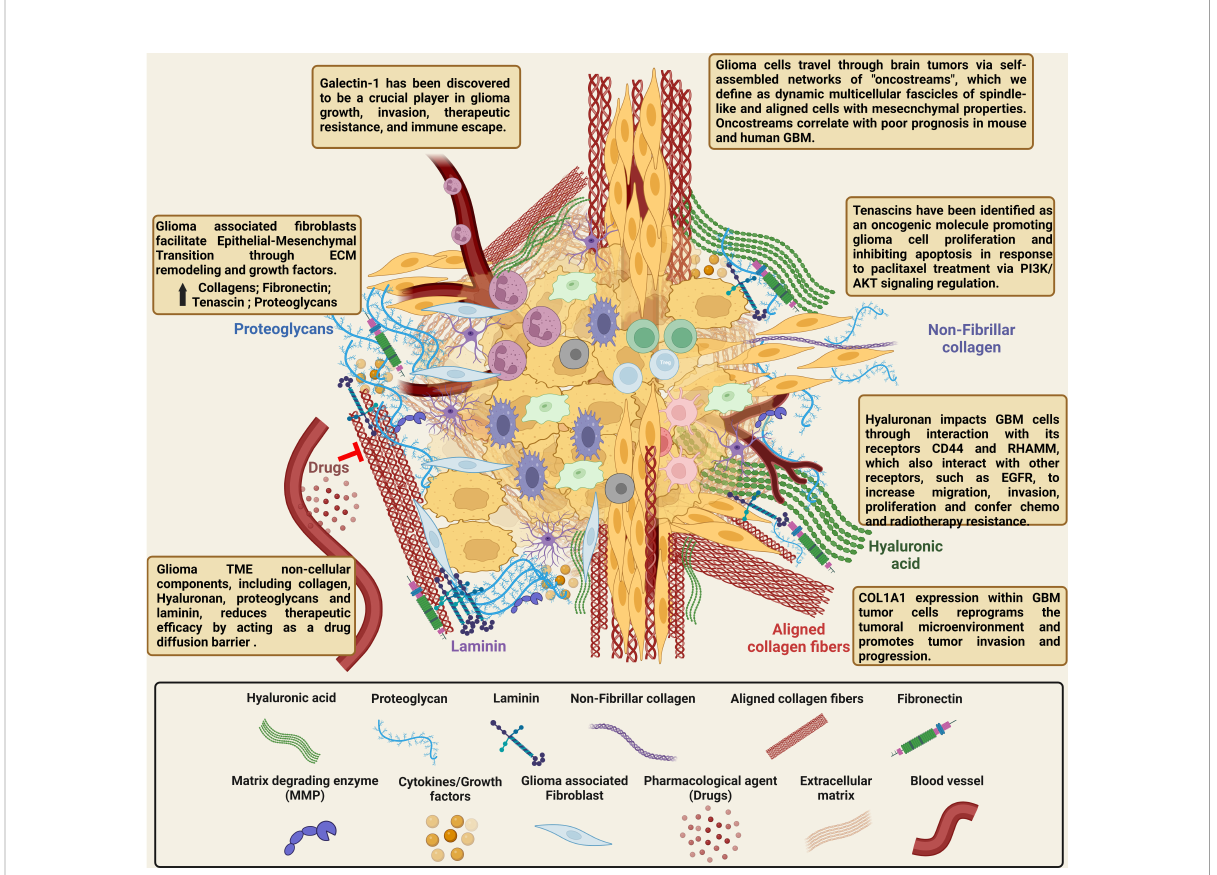
FIGURE 2 Illustration of the complex cellular and non-cellular ECM interactions in the glioma tumor microenvironment. The normal brain ’ s ECM differs from that of other organs because it contains very little of the fi brotic ECM proteins collagen, fi bronectin, and laminin. On the other hand, the brain parenchyma is abundant in proteoglycans, connecting proteins, and glycosaminoglycans (hyaluronic acid). The ECM is transformed in GBM tumors compared to healthy brain tissue, and it is crucial for tumor invasion and migration. The ECM of GBM contains higher levels of collagen, fi bronectin, laminin, hyaluronic acid, tenascin C, and vitronectin, all of which have been linked to glioma growth, invasion, and chemo- and radio-resistance. Due to the complex interactions between glioma cells and the non-cellular components in the GBM TME, targeting the ECM directly and attempting to alter the tumor production of ECM proteins, and thereby reduce tumor growth, should improve the in fi ltration of immune cells, drugs and provide improved therapies for highly malignant brain tumors. [Created with